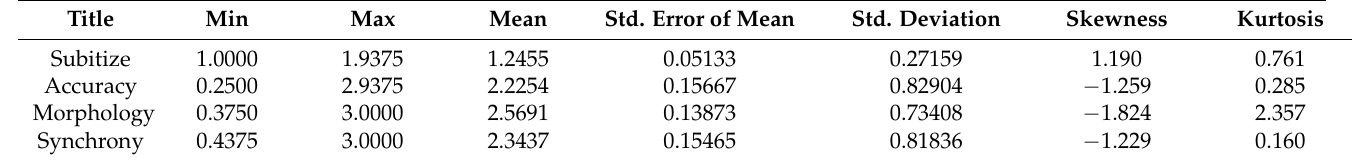
Table 9. Gestural Ability Descriptive